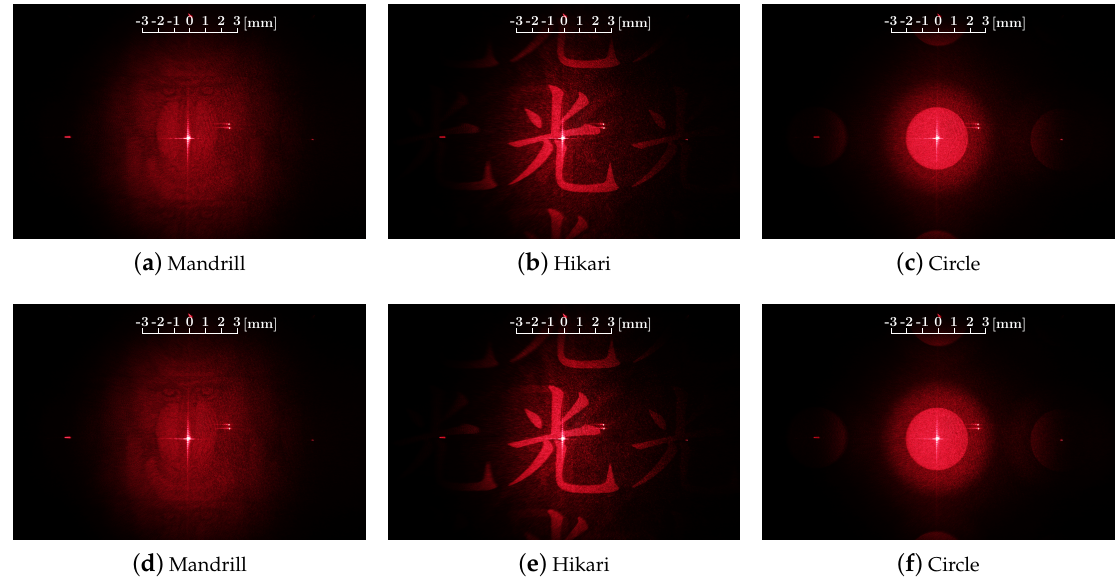
Figure 12. Experimentally obtained reconstructed images: ( a – c ) were reconstructed images obtained by the proposed algorithm, ( d – f ) were those obtained by the GS algorithm. ( a , d ) are “mandrill”, ( b , e ) are “hikari”, and ( d , f ) are